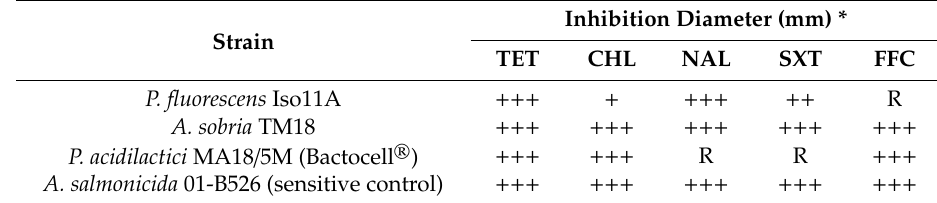
Table 3. Antimicrobial susceptibility profiling of candidate probiotic strains used in this study. Inhibition Diameter (mm) * Strain